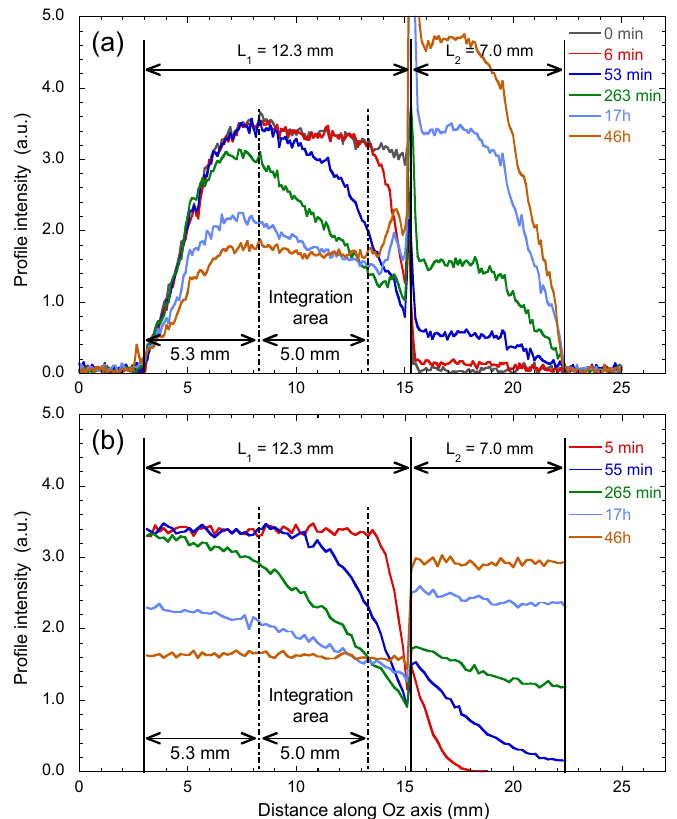
Figure 20. Time evolution of the water concentration profiles within water saturated kaolinite sample after addition of external heavy water. The experimental profiles are obtained by using 1 H Mag- netic Resonance Imaging ( a ) and compared to numerical data obtained by Brownian Dynamics ( b ). Reprinted with permission from Ref. [51]. Copyright (2018) American Chemical